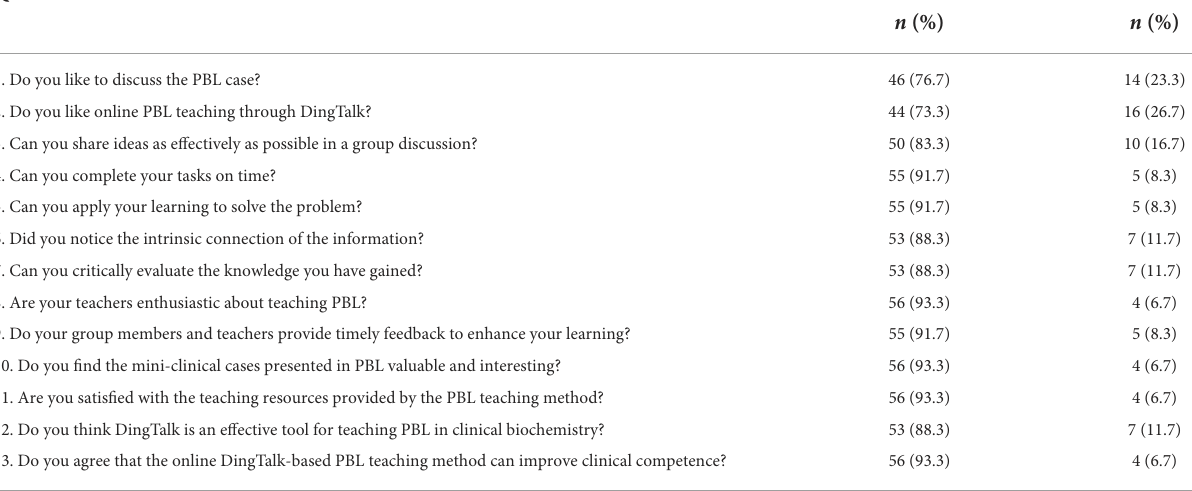
TABLE 4 Findings of DingTalk-based virtual simulation